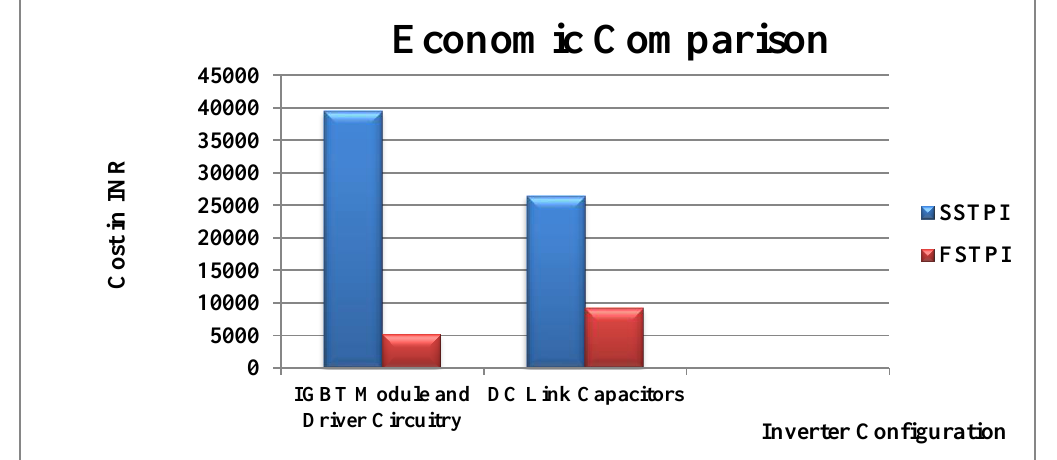
Figure 5. Economic comparison between SSTPI and FSTPI